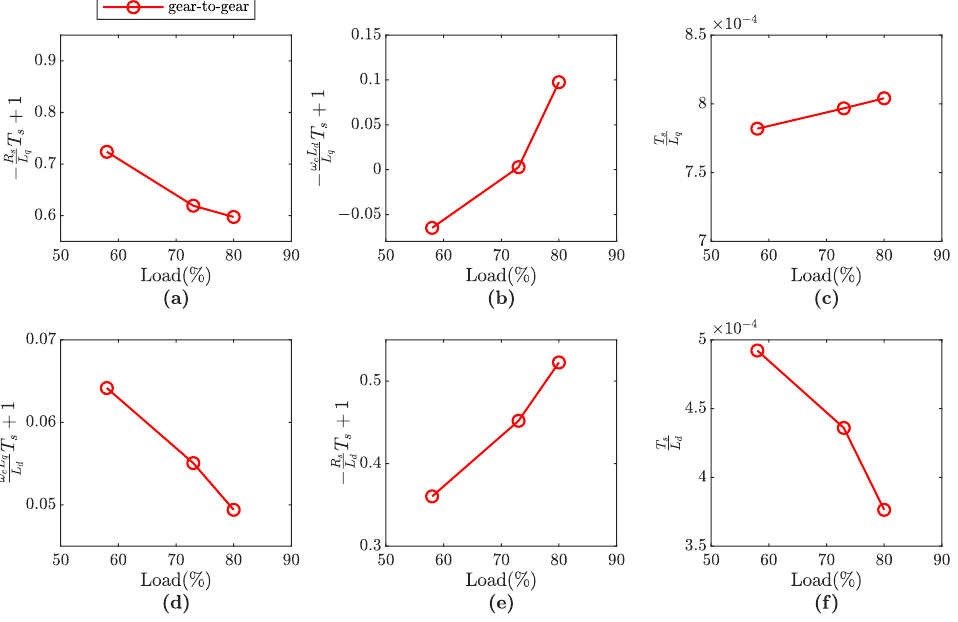
Figure 12. Identified PMSM lumped parameters with gear-to-gear transmission in 58%, 73%, and